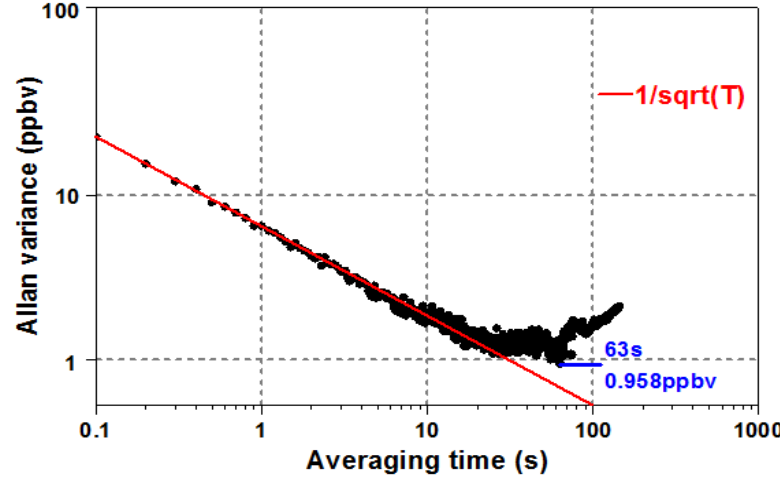
Figure 6. Allan variance of 1 ppmv C 2 H 2 .